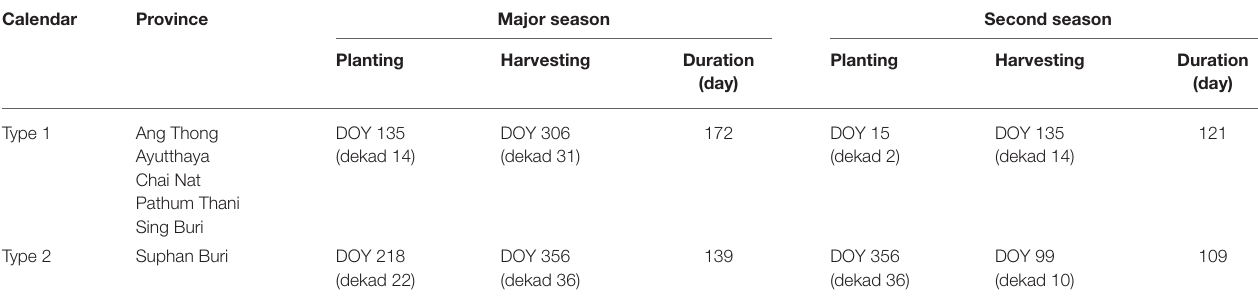
TABLE 2 | Rice calendars in the target provinces according to RiceAtlas (Laborte et al.,